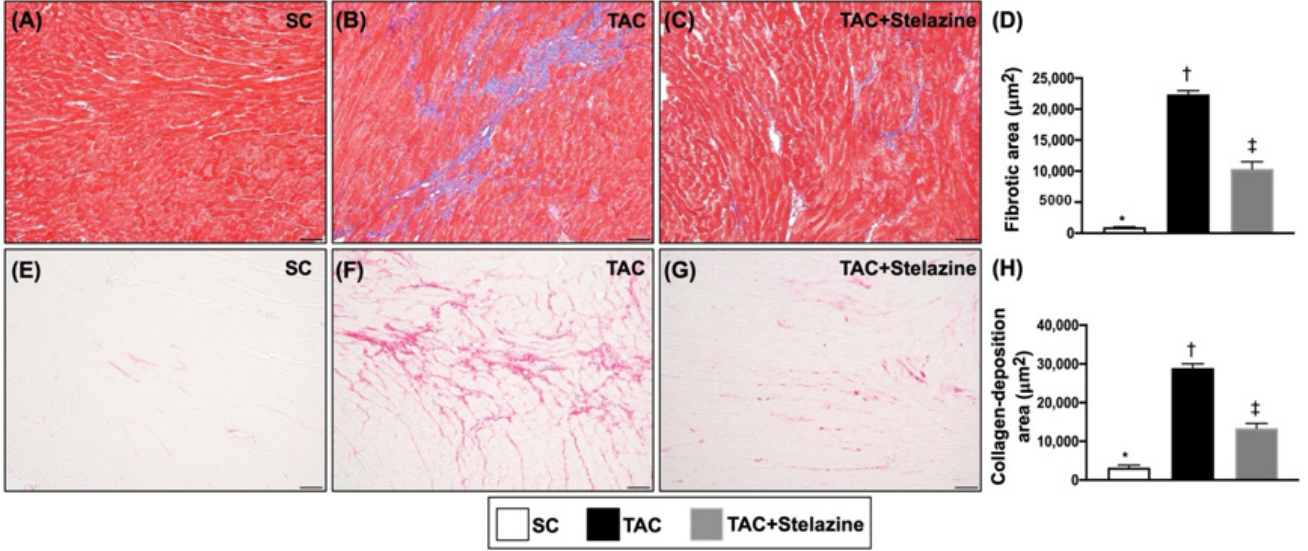
Figure 8. Fibrotic and collagen-deposition areas in LV myocardium by day 28 after TAC procedure. ( A – C ) Illustrating the microscopic finding (200×) of Masson’s trichrome staining for identification of fibrosis (blue color). ( D ) Analytical result of fibrotic area, * vs. other groups with different symbols (†, ‡), p < 0.0001. ( E – G ) Illustrating the microscopic finding (200×) of Sirius red staining for identification of collagen-deposition area (pink-red color). ( H ) Analytical result of collagen-deposition area, * vs. other groups with different symbols (†, ‡), p < 0.0001. All scale bars in right lower corner represent 20 µ m. Symbols (*, †, ‡) indicate significance (at 0.05 level). SC = sham-operated control; TAC = transverse aortic constriction; LV = left ventricular.